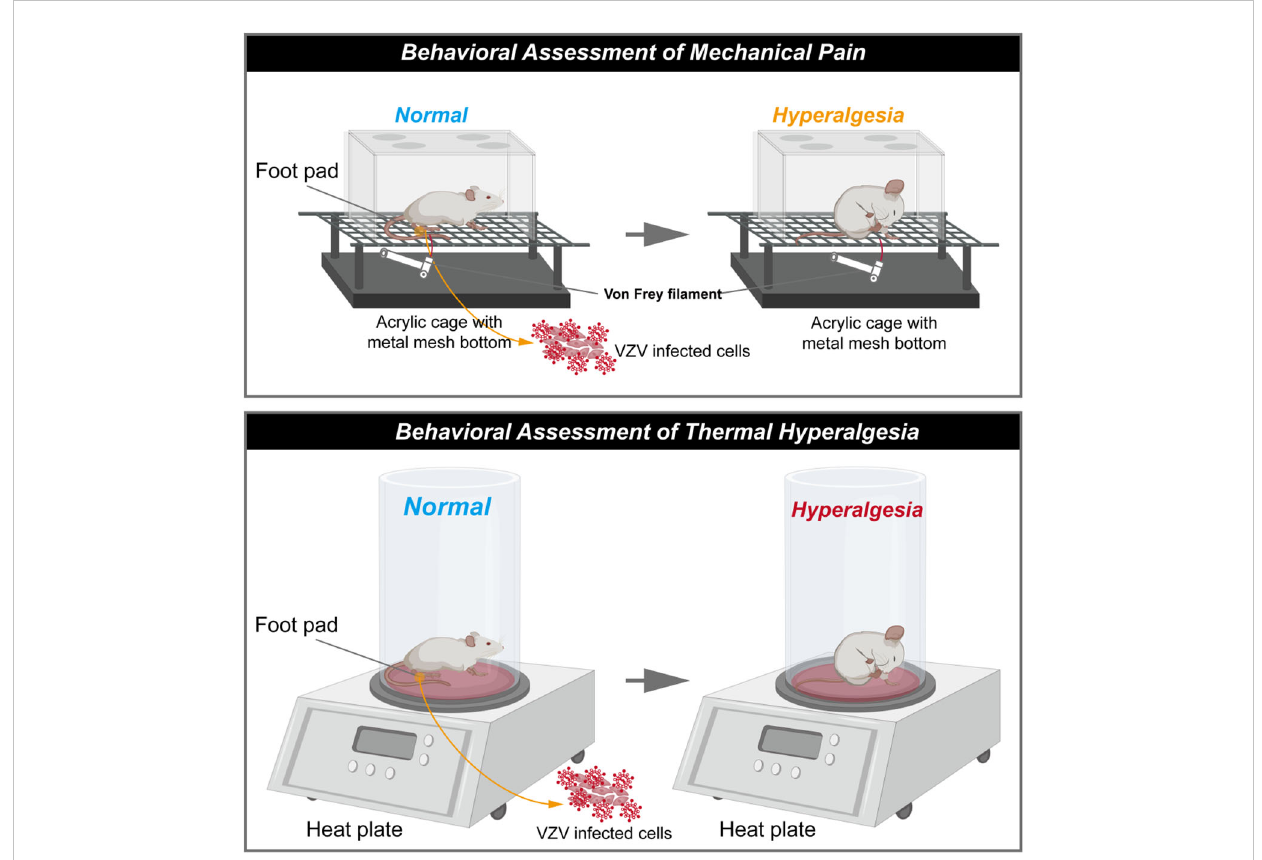
FIGURE 1 Schematic diagram of rat model of postherpetic neuralgia induced by VZV. (The schematic was drawn by Figdraw, https://www. fi gdraw.com/static/